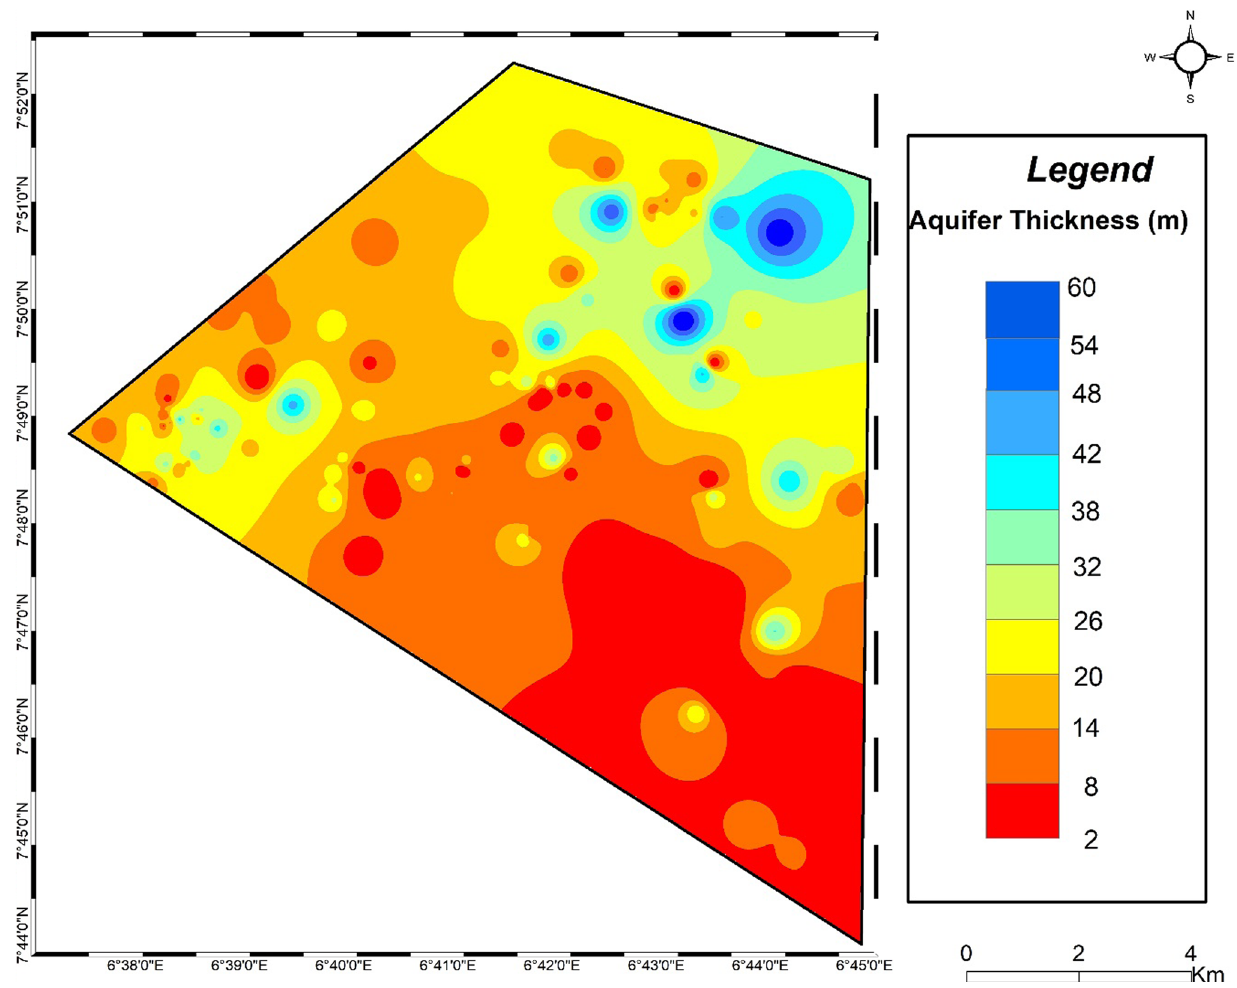
Fig. 6 Map showing the spatial distribution of aquifer thickness across the study